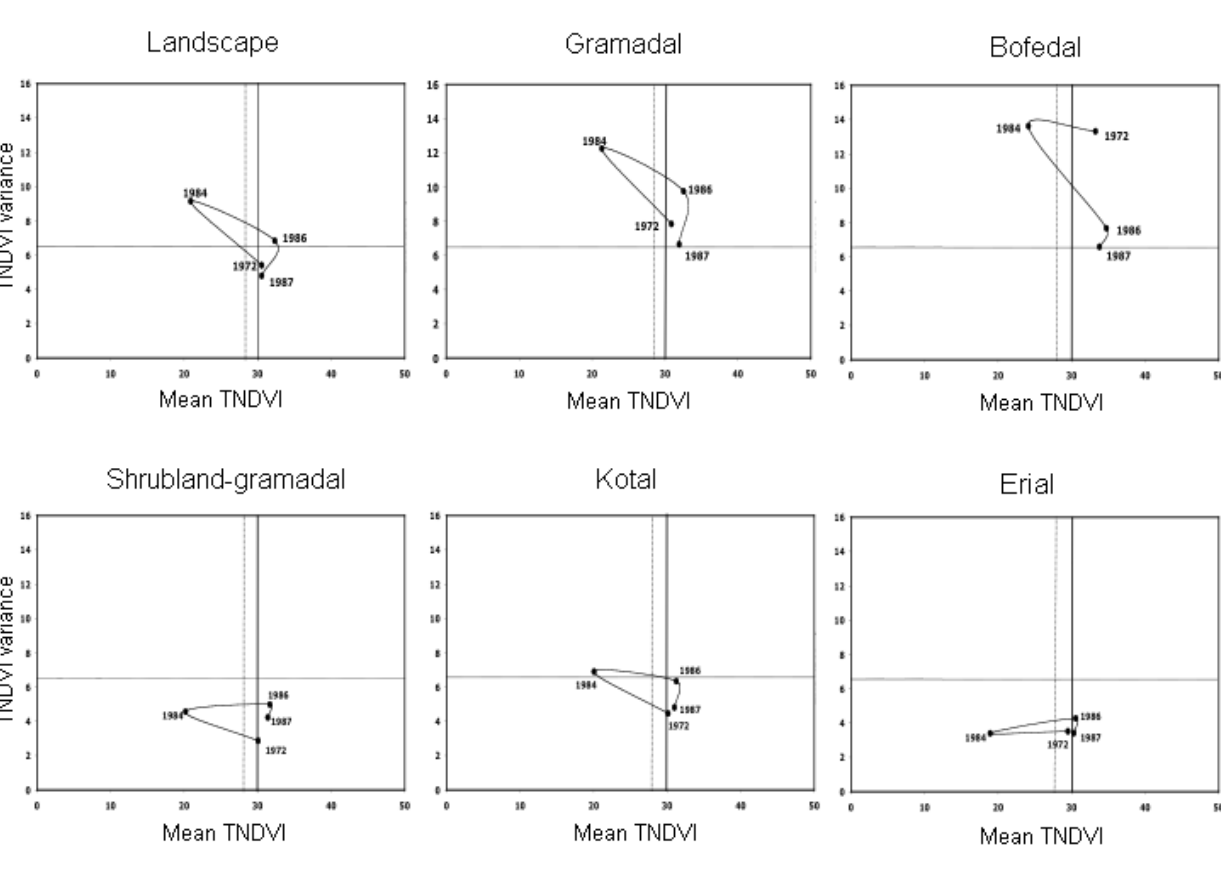
Fig. 3. Mean-variance dynamical portraits of the transformed normalized difference vegetation index (TNDVI) response of San Jose Llanga from 1972 to 1987 at the landscape and vegetation cover class spatial scales. Temporal dynamics are shown with respect to the landscape’s mean TNDVI and mean TNDVI variance and a calibrated 20% vegetation cover line (dotted line). The 1984 vegetation index scene is representative of a severe